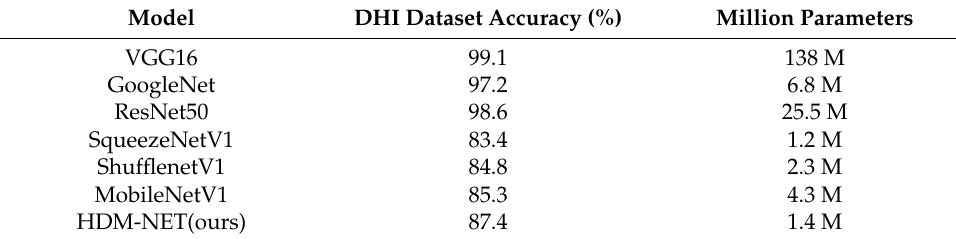
Table 3. Parameters and results of general CNN models on DHI datasets.